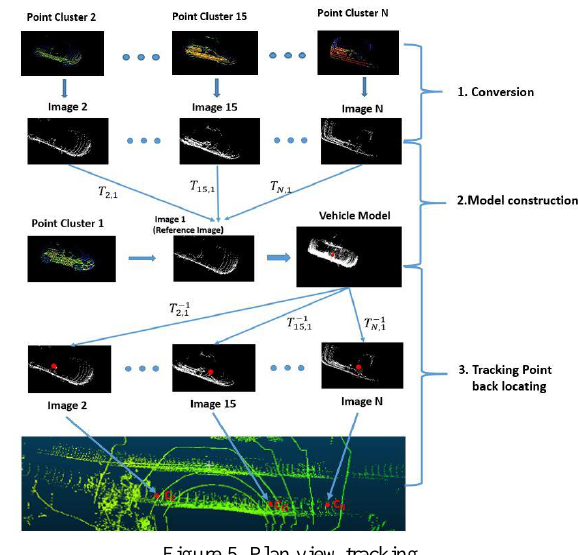
Figure 5. Plan view tracking.